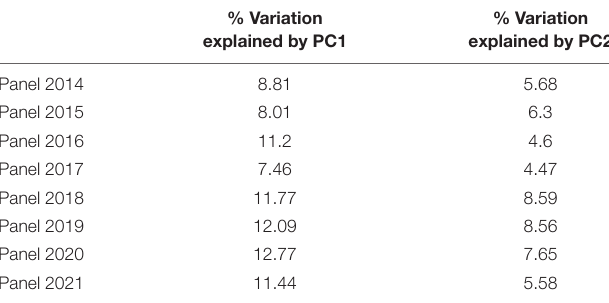
TABLE 4 | Principal component analysis (PCA) of the SABWGPTY panels obtained based on single-nucleotide polymorphism (SNP) genotyping. % Variation % Variation explained by PC1 explained by